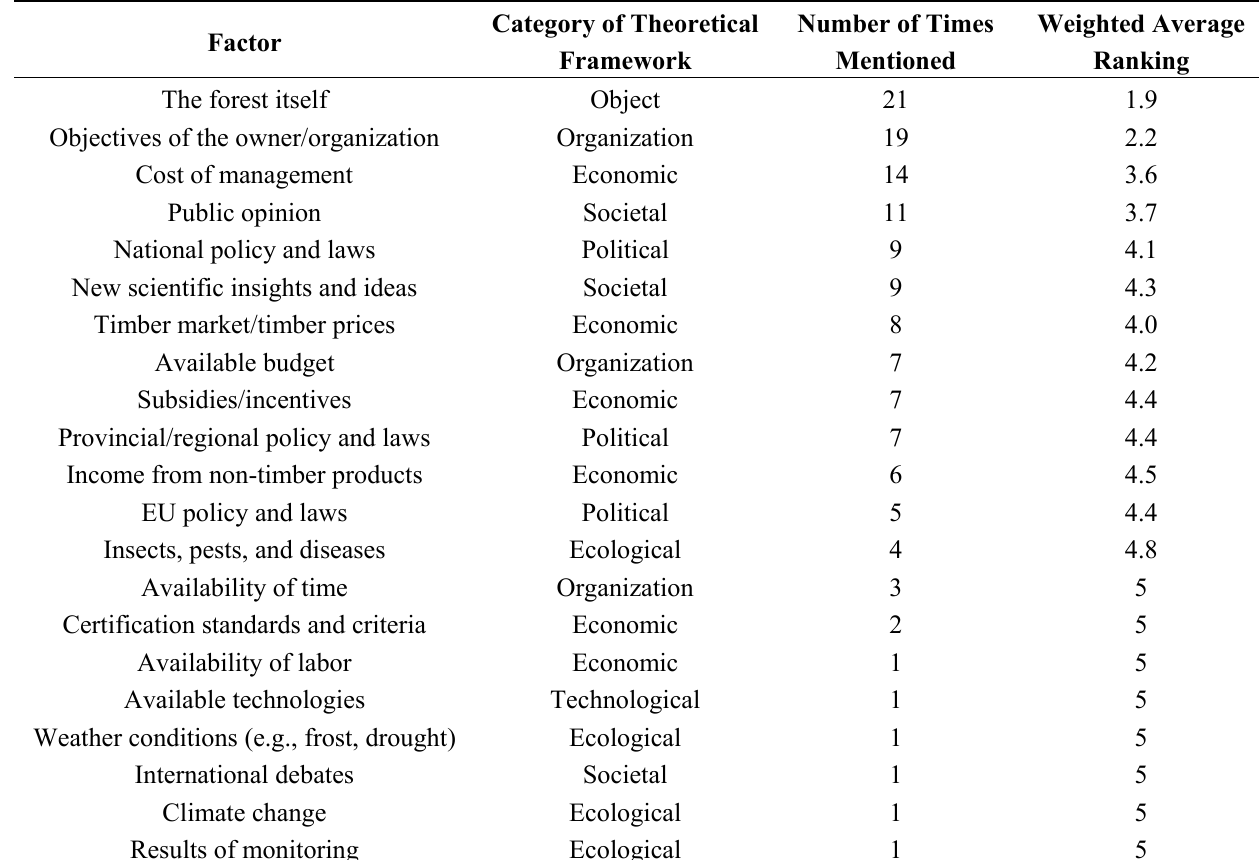
Table 2. List of factors the respondents indicated as most relevant to their decision-making ( N =